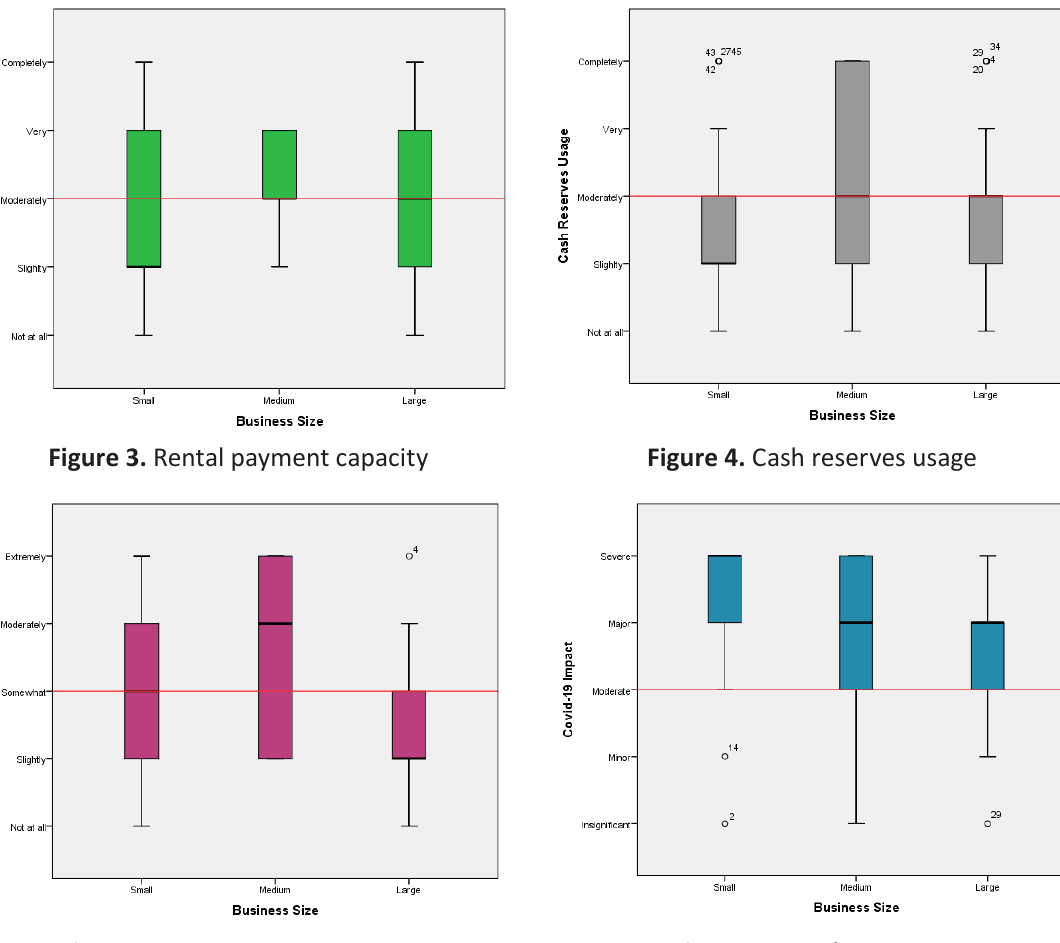
Figure 5. Costumer